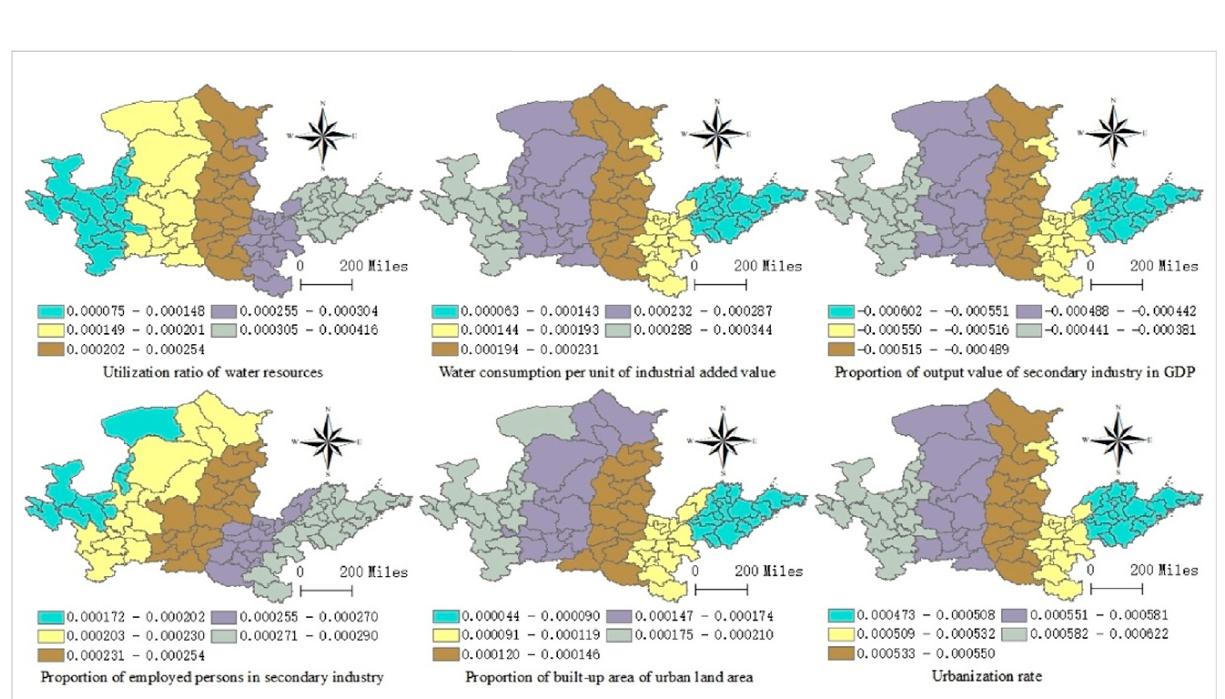
FIGURE 6 Spatial distribution of estimated coef fi cients of water resources utilization, industrialization and